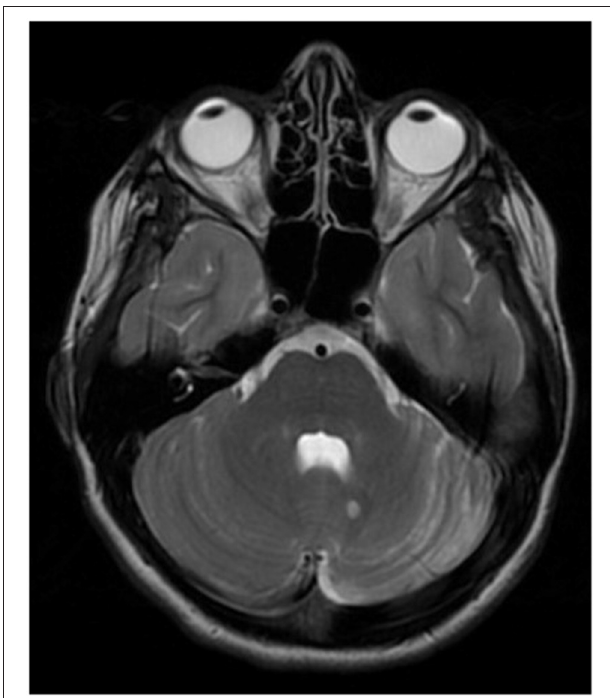
FIGURE 1 | T2 sequence of brain MRI demonstrating hemi-atrophy of the left cerebellum in addition to a 6mm T2-hyperintense lesion near the cerebellar vermis on the left. Additional brain imaging not show any further T2/FLAIR (fluid-attenuated inversion recovery) abnormalities in the cerebellum, cerebrum or corpus callosum (sequences not